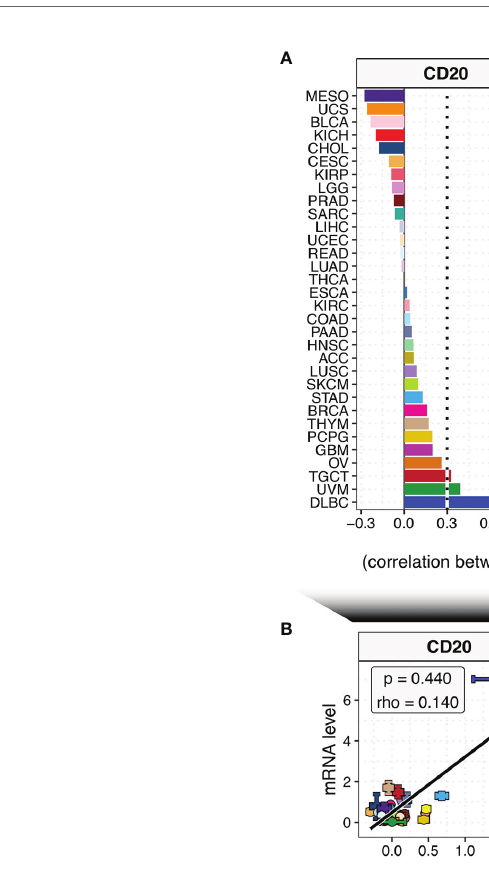
FIGURE 2 | The relationships between the mRNA and protein levels of CD20 and LCK across different cancer types. (A) Bar plot shows the Spearman ’ s rho coef fi cients between mRNA and protein levels of CD20 and LCK in different cancer types, with color coding according to cancer type. (B) The correlations between mRNA and protein levels of CD20 and LCK in pan-cancer analysis. The error bar represents the 95% con fi dence interval (CI), the dot represents the average value, with color coding according to cancer